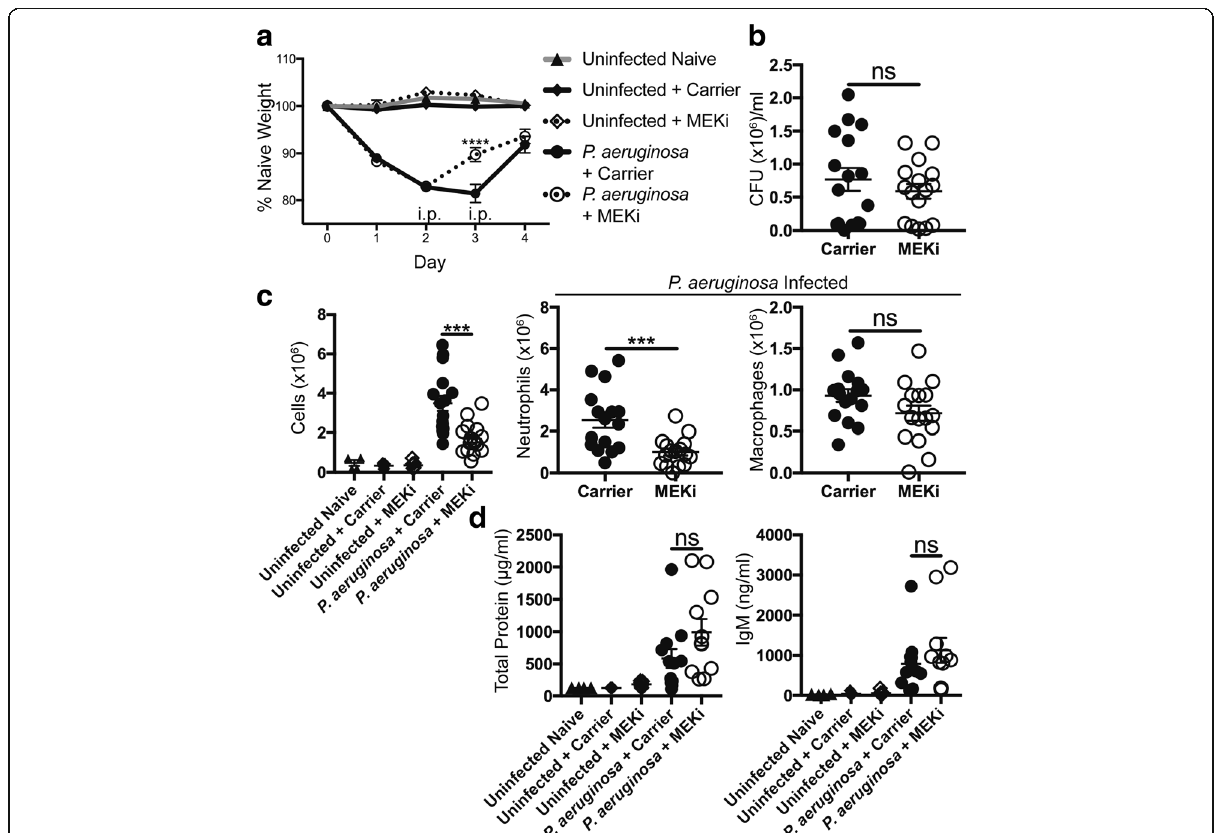
Fig. 1 MEKi delivered after P. aeruginosa infection reduces inflammation without impairing bacterial clearance. C57BL/6J mice were infected with a target inoculum of 5 × 10 6 CFU of P. aeruginosa by oropharyngeal instillation. a Animal weight was monitored over 4 days and IP injections of PBS + MEKi or PBS + carrier control were given to groups on days 2 and 3 post-infection. Mice receiving MEKi had significantly reduced weight loss on day 3 compared to carrier-treated animals, while treatments of uninfected mice did not alter animal weight. Data shown are mean ± SEM of 7 mice for each P. aeruginosa infected group from one representative experiment of three; the weights from additional controls of uninfected naïve ( n = 4), uninfected carrier-treated ( n = 7), and uninfected MEKi-treated ( n = 7) are also included in this graph. Two-way ANOVA with Bonferroni ’ s multiple comparisons was used to analyze results. b Animals were euthanized 4 days after infection and lungs were homogenized in sterile PBS and plated for colony-forming unit (CFU) enumeration. There was no statistical difference in lung CFU between P. aeruginosa infected carrier and MEKi-treated groups ( n = 16/group), demonstrating that bacterial clearance was not impaired by MEKi-treatment. c Total BAL cells, neutrophils and macrophages were enumerated and identified on Diff-quick cytospin preparation ( n = 16/ P. aeruginosa infected group) and analyzed by parametric unpaired t -test. d Cell-free BALF was used to measure total protein and IgM (carrier n = 12, MEKi n = 11) and were analyzed by nonparametric Mann-Whitney t -test. Error bars show the mean ± SEM. *** p < 0.001, **** p < 0.0001, ns not